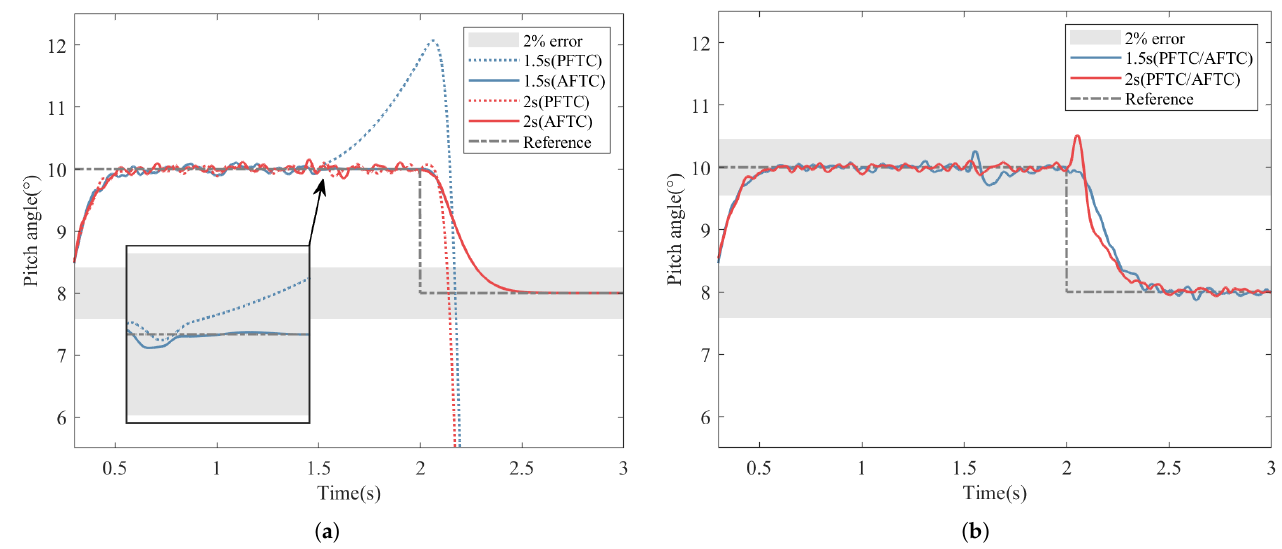
Figure 12. Comparative results of the proposed ADRC-based active fault-tolerant control for QUAV. ( a ) With the stuck fault. ( b ) With the outlier-data fault.